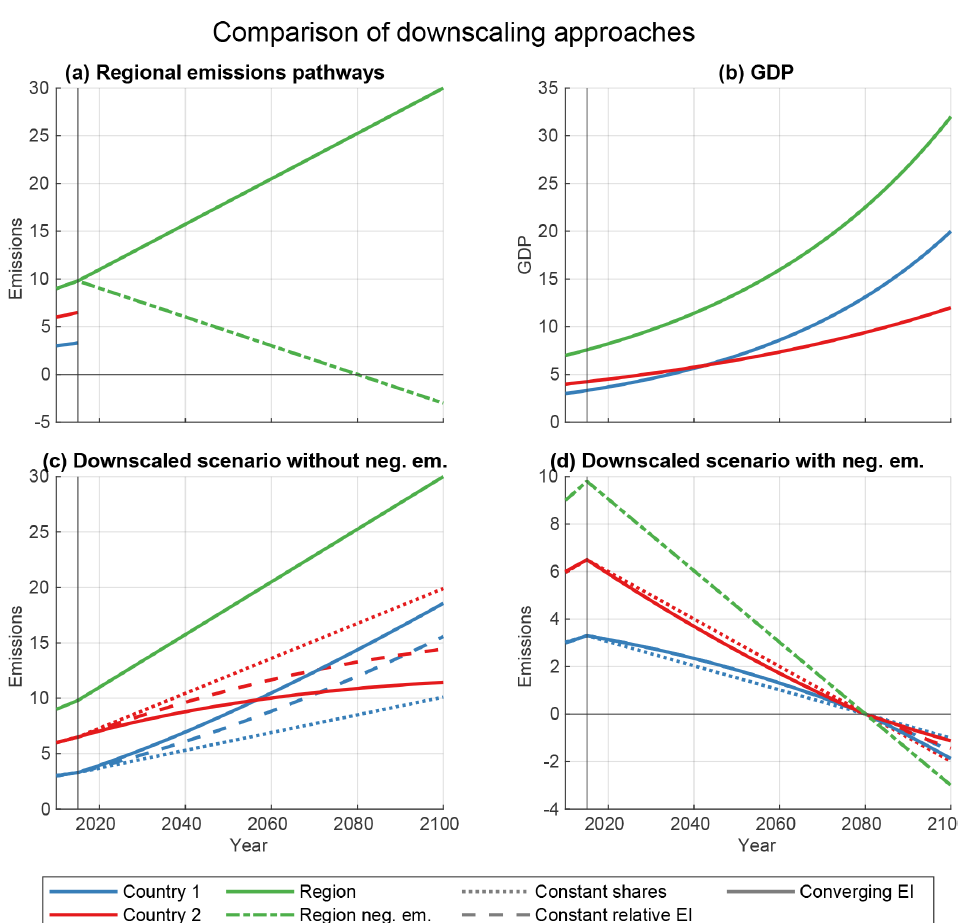
Figure 1. Example results for different downscaling approaches. For the sake of simplicity a two-country region is assumed. The constant- relative-emission-intensity downscaling is a variation of the external-input-based downscaling, where we use GDP as external input, and the assumption of constant relative emission intensities to create emission pathways based on the GDP data (b) . Regional emission data are given for the whole time period, while for the countries only historical data are available (a) . Panel (c) shows downscaling for increasing emissions. It is clearly visible that the constant-share downscaling does not account for the GDP development, while the convergence downscaling leads to the highest emissions of country 2 because it considers not only GDP growth but also converging emission intensities between the two countries. Panel (d) shows downscaling for a transition to negative emissions. For convergence downscaling the convergence is set to the year directly before the transition to negative emissions. The rapid reductions and early convergence lead to similar pathways for all methods before the transition to negative emissions. After the transition the effect of considering GDP is visible. The convergence year for convergence downscaling is 2150 in this